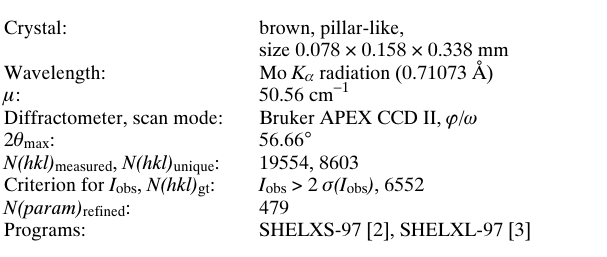
Table 1. Data collection and